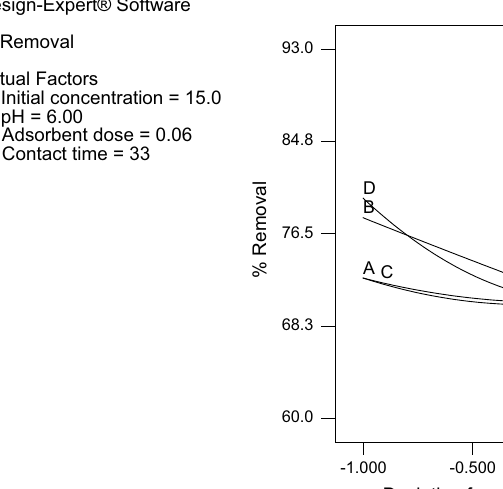
Fig. 3 Perturbation plot of car-